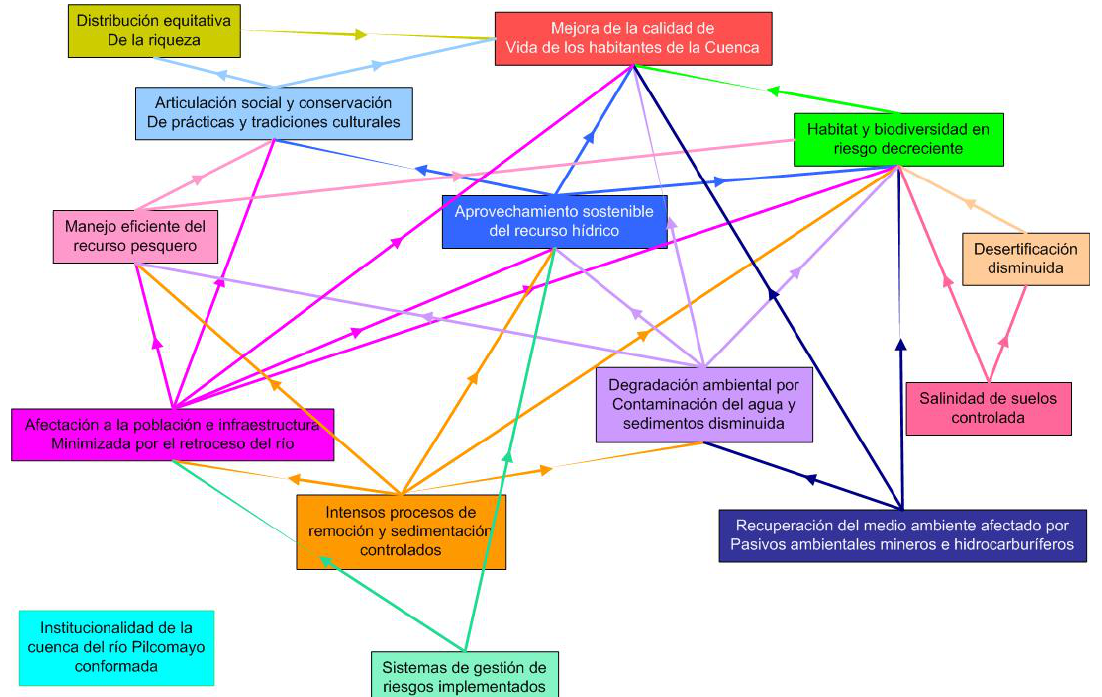
Figura Nº 6: Esquema árbol integrado de objetivos. Proyecto Pilcomayo.